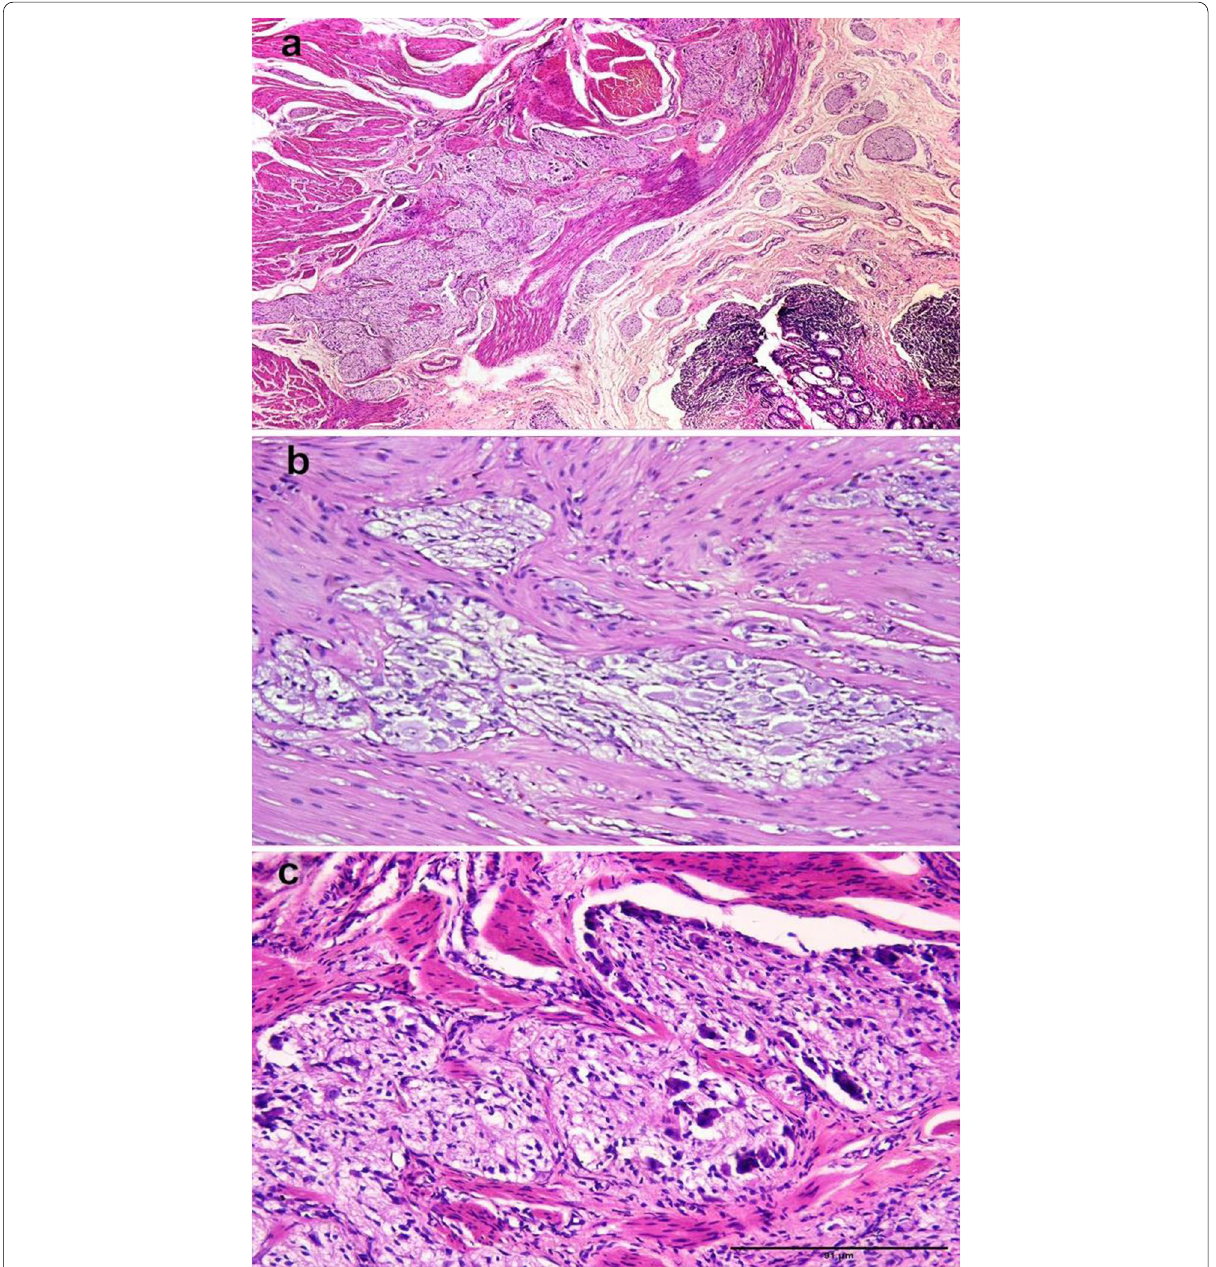
Fig. 2 Intestinal neuronal dysplasia by H&E: Giant ganglia and hypertrophied submucosal and myenteric nerve plexuses (H&E, power view showing giant ganglia with large and small neurons as well as hypertrophied myenteric nerve plexus